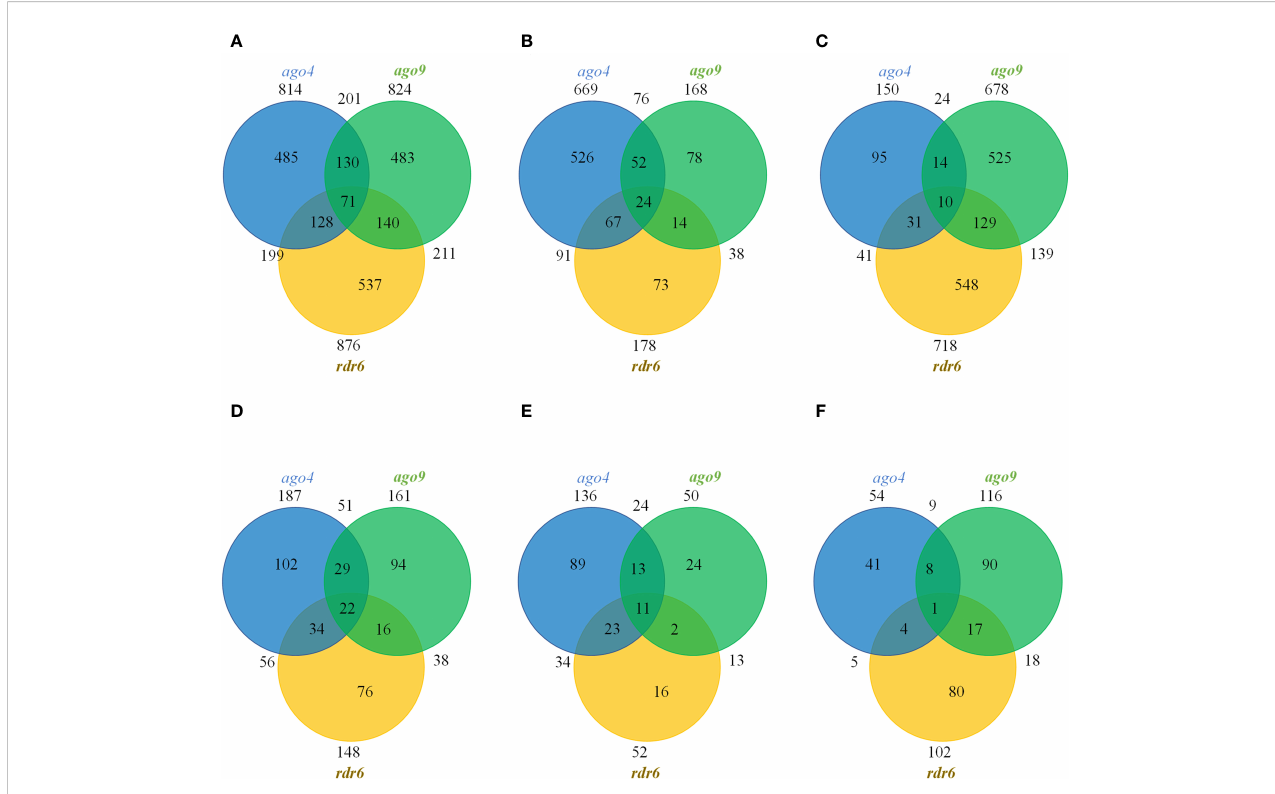
FIGURE 3 Venn distribution of TEs and genes mapping to DMRs in the CHH context. (A) Total number of DMRs containing TEs. (B) Total number of hypomethylated DMRs containing TEs. (C) Total number of hypermethylated DMRs containing TEs. (D) Total number of DMRs containing genes. (E) Total number of hypomethylated DMRs containing genes. (F) Total number of hypermethylated DMRs containing